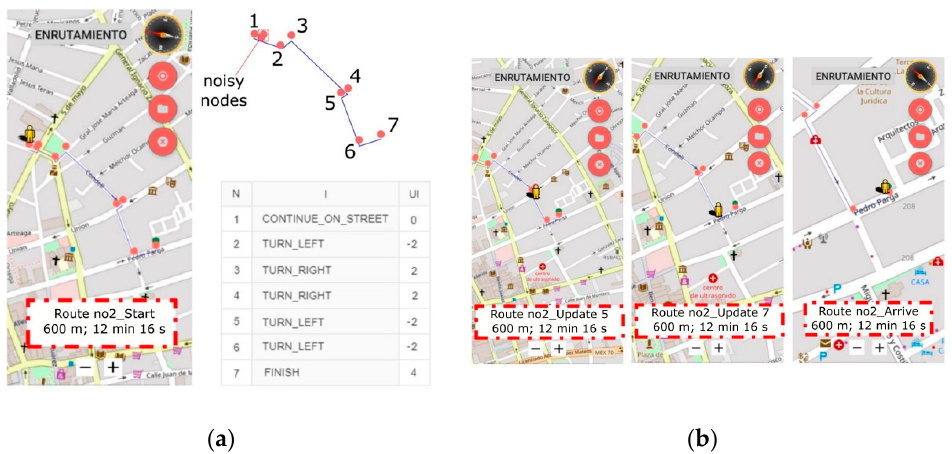
Figure 12. The second environment proposed to the subjects: ( a ) the path involved seven nodes and two noisy nodes that were neglected. ( b ) Some snapshots of subject B during the task.